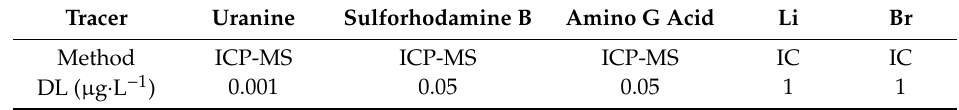
Table 5. Analytical methods and detection thresholds for the analyzed tracers. Tracer Uranine Sulforhodamine B Amino G Acid Li Br Method ICP-MS ICP-MS ICP-MS